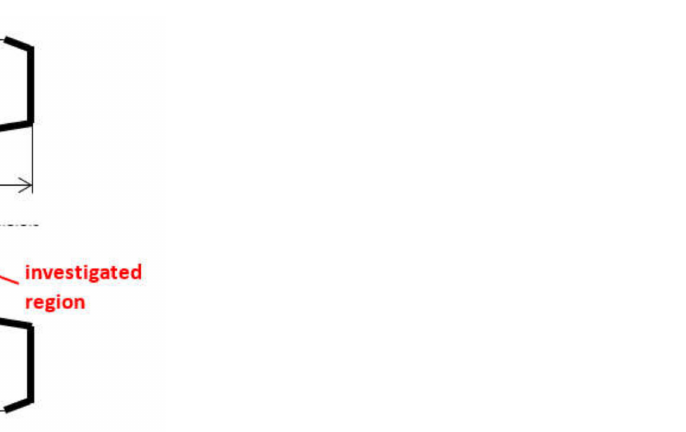
Figure 1. Profile of the flange NH4 with dimensions, highlighted investigated region, and the directions of MBN measurements.